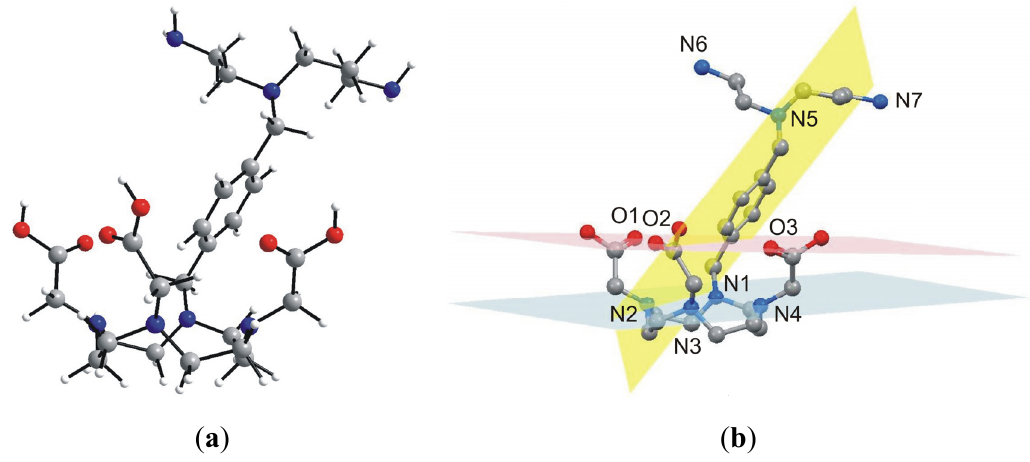
Figure 6. Geometry of 5 optimized at the B3LYB/6-311G * level of theory ( left , a ), showing selected least-square planes ( right , b ) going through the macrocyclic nitrogen atoms N1–N4 (blue), the carboxylic oxygen atoms O1–O3 (red) and the benzene ring (yellow). Hydrogen atoms are omitted for clarity